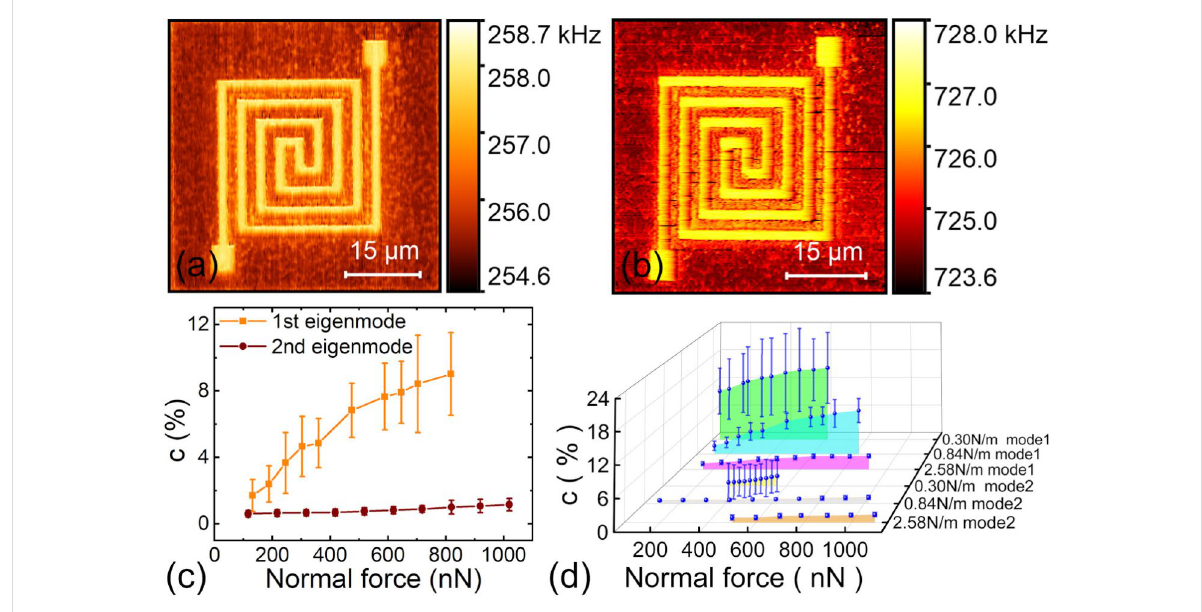
Figure 5: The influence of cantilever oscillation eigenmode on CR-AFM subsurface imaging of a flexible circuit sample with a top layer thickness of 52 nm. (a,b) Tracked resonance frequency images of the first and the second eigenmodes of the PPP-FM probe under a normal force of 818 nN. (c) Experimental contact stiffness contrast of the first two eigenmodes under various normal forces. (d) Stiffness contrast when using different cantile- vers and different eigenmodes.